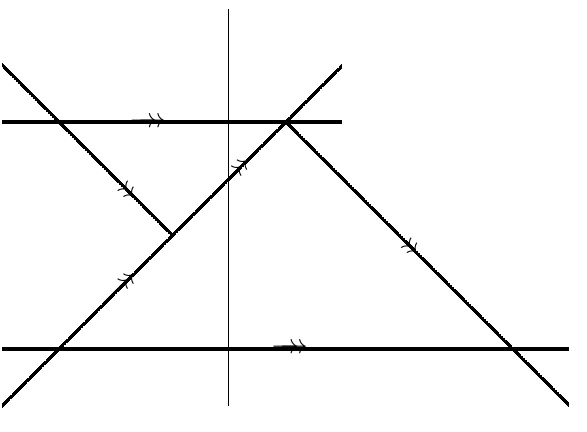
Figure 11 . A reduced diagram labelling the direction of (cid:13)ow of Im ( ‘ 1 double arrows and always from left to